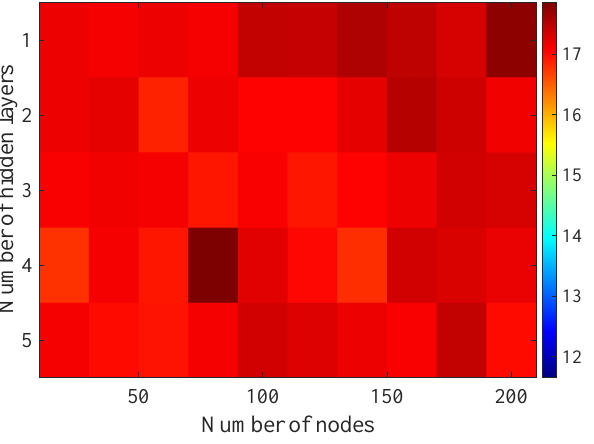
Figure 8. Matrix of the BLER RMSE metric predictions for the instantaneous values of radio parameters.